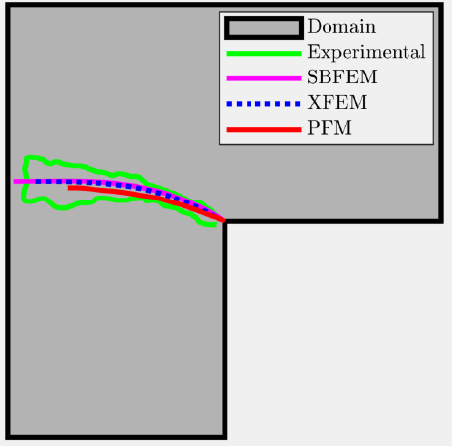
Figure 34. LSP crack paths for SBFEM, XFEM and PFM.